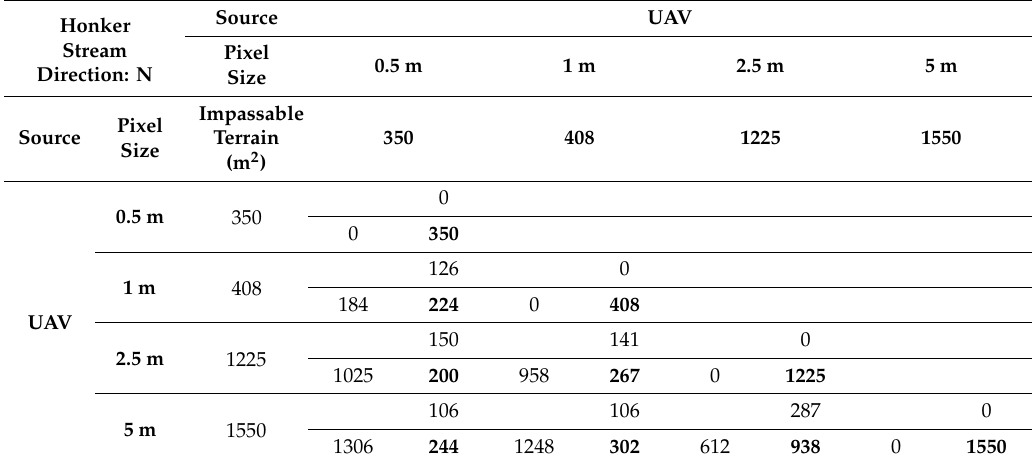
Table 11. Intersection between impassable areas of the Honker moving northward in stream terrain (UAV